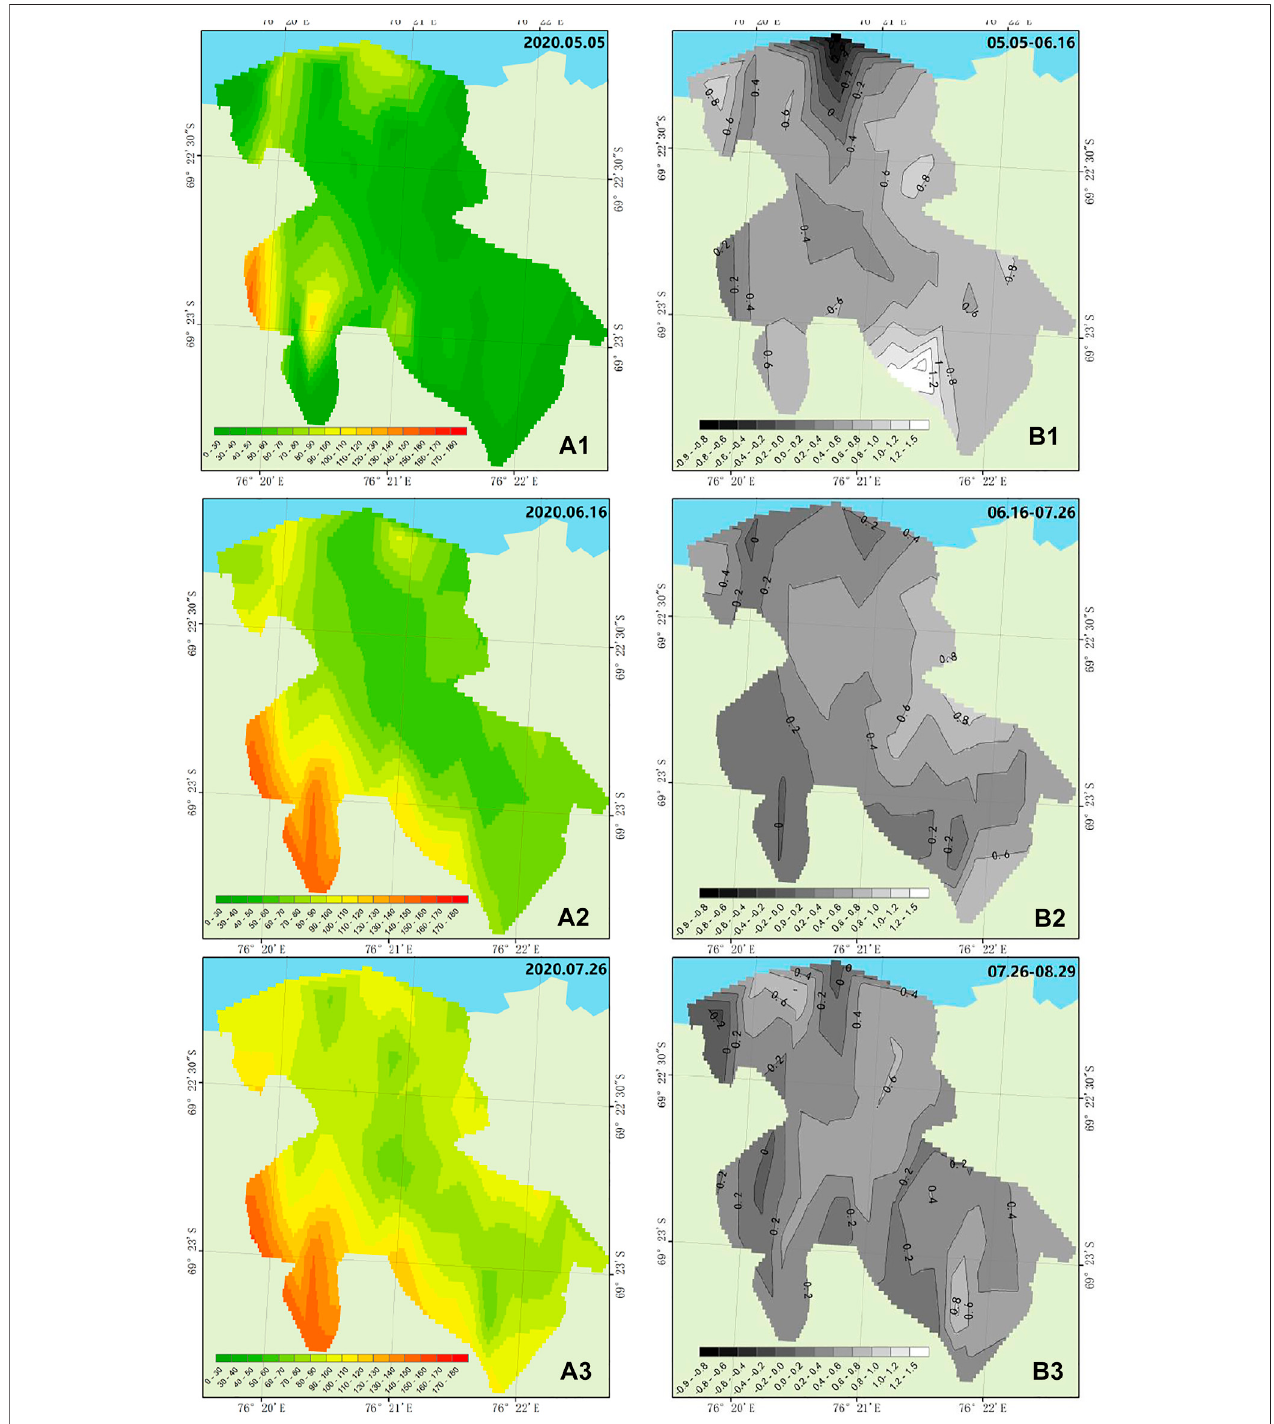
FIGURE 3 | The spatiotemporal changes in ice thickness (cm). (Panels (A1-A7) : Spatial distribution of sea ice thickness on May 5, June 16, July 26, August 29, October9,November14andDecember6;Panels (B1-B6) :SpatialdistributionofseaicethicknessgrowthratefromMay5toJune16,fromJune16toJuly26,fromJuly 26 to August 29, from August 29 to October 9, from October 9 to November 14 and from November 14 to December 6; Panel (B7) : Average sea ice thickness in the 7 periods).